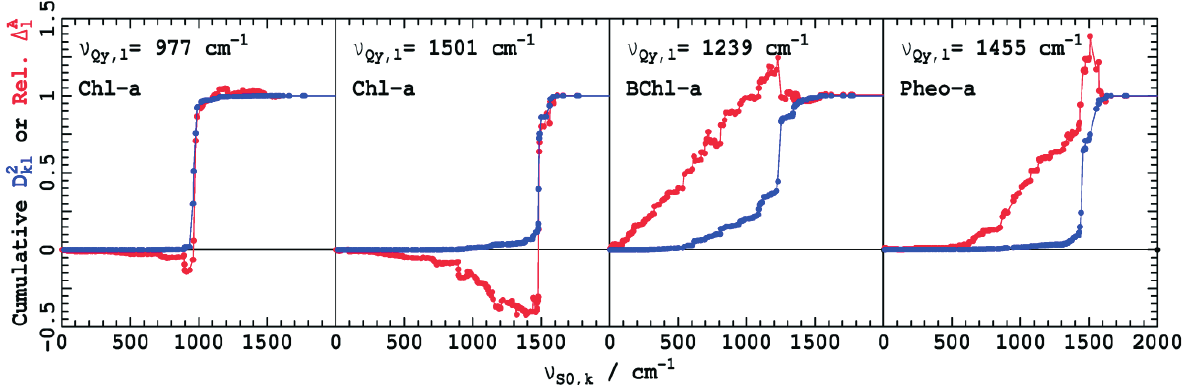
2 (blue) and the relative contribution to the 𝑘𝑙